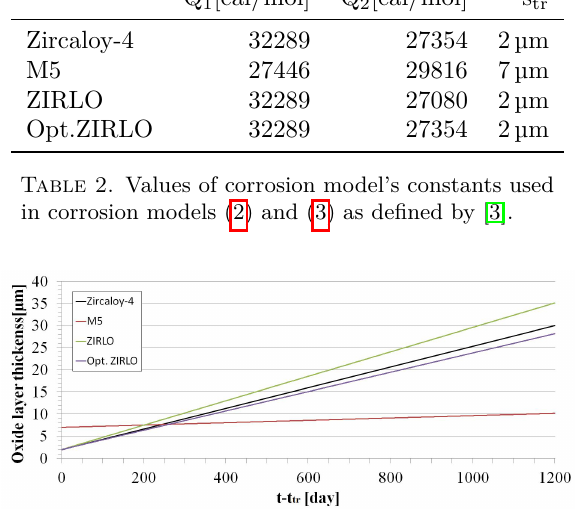
Figure 2. Zirconium dioxide layer development from the point of reaching first transition thickness s tr corre- sponding to the transition time t tr . Axis x represents time in days after the moment, when transition thick- ness was reached. The temperature of 320 ◦ C and neutron flux of 1 × 10 15 neutrons / m 2 s were chosen in this model situation.